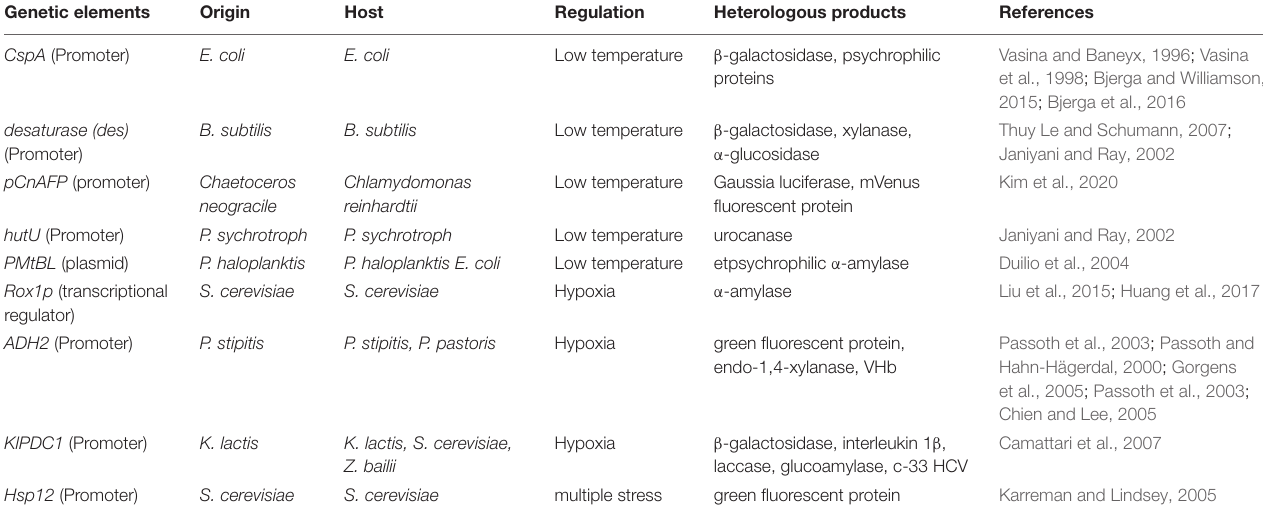
TABLE 1 | stress induction related genetic elements used for heterologous protein